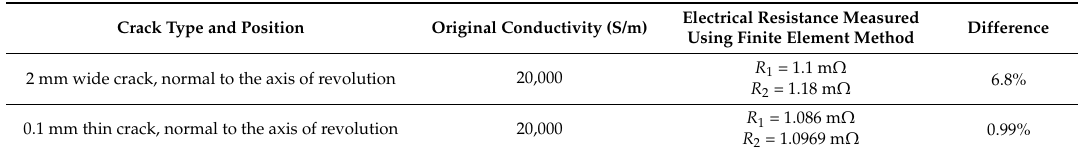
Table 5. Difference for two contiguous resistances for a sample containing a crack normal to the axis of rotation, calculated using the FEM